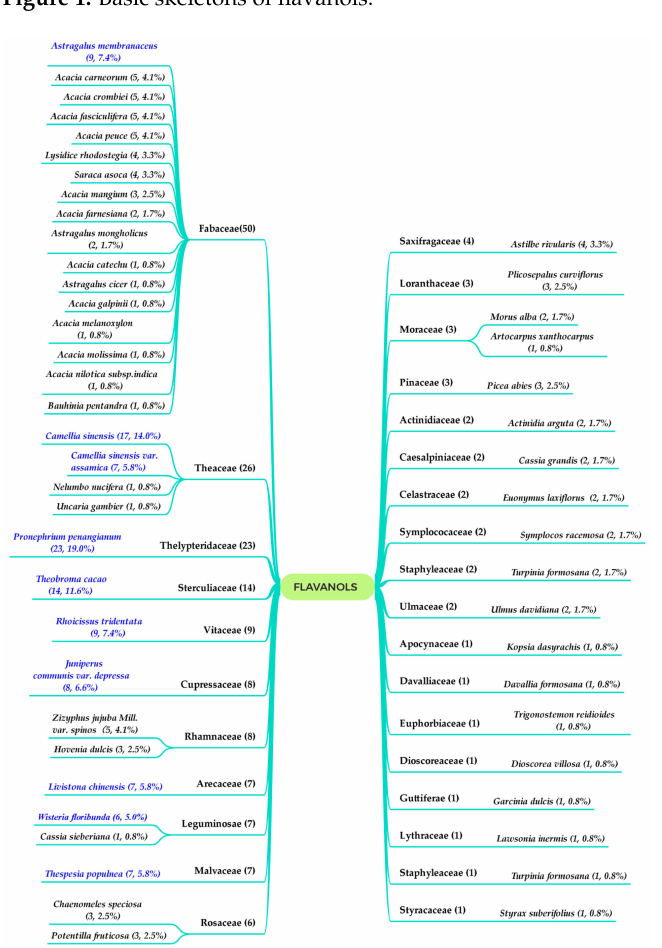
Figure 1. Basic skeletons of flavanols.